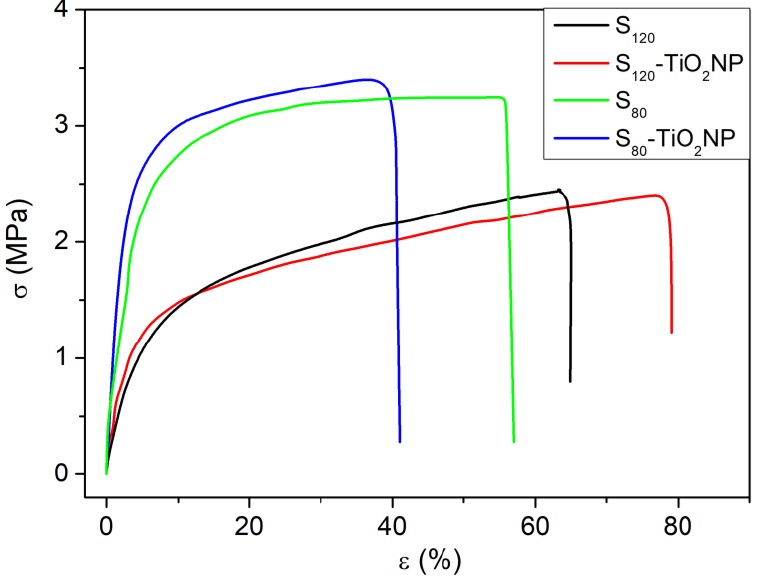
Table 3. Results of the Young’s modulus (E), stress at break ( 𝝈 b ), strain at break ( 𝜺 b ), tensile toughness (T), and the parameters from the theoretical Kohlrausch – Williams – Watts (KWW) model ( 𝝉 * and β ). Figure 6. Tensile stress ( σ )–strain ( ε ) curves of S 80 , S 80 -TiO 2 NP, S 120 and S 120 -TiO 2 NP.